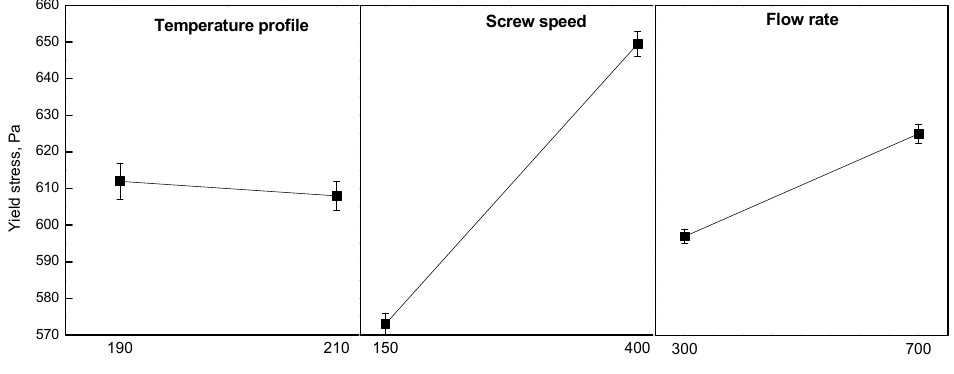
Figure 3. Plot of process parameters effect for yield stress for 70PPt.